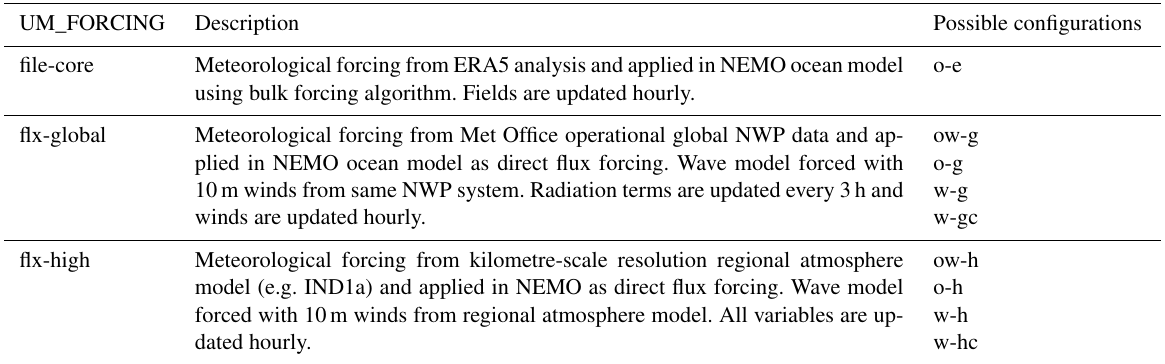
Possible configurations